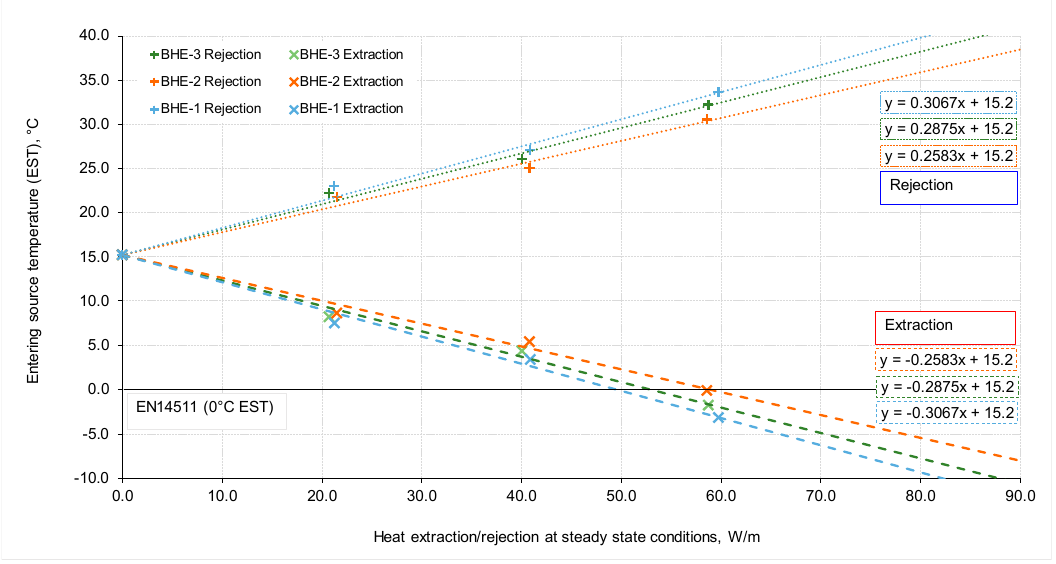
Figure 8. Determining the extraction/rejection heat for three different pipe configurations.